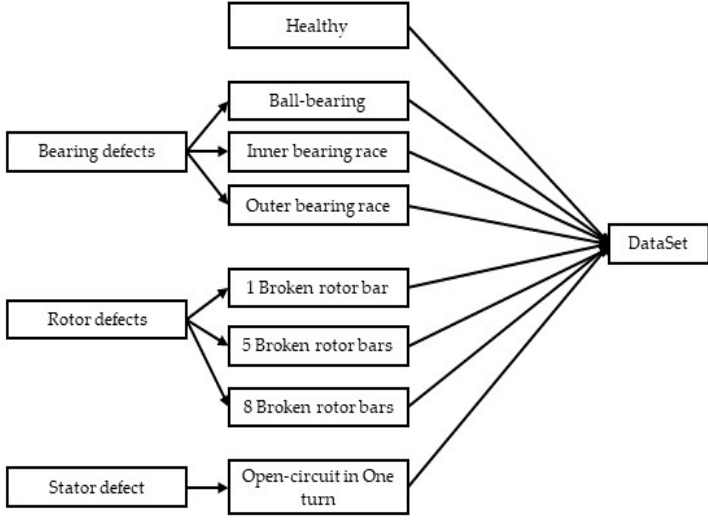
Figure 2. Block diagram of data sources.